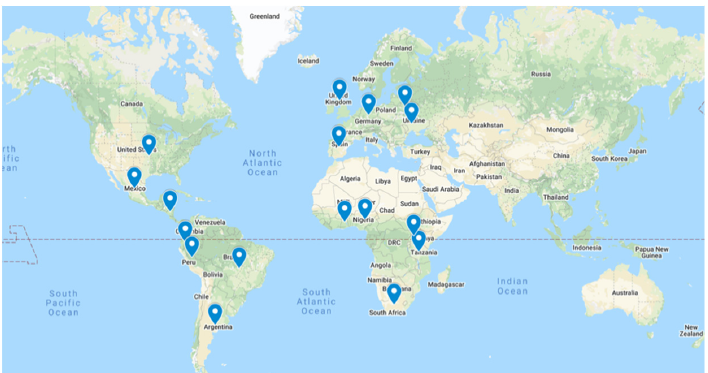
Figure 5. Distribution of National DSpace User Groups worldwide (as of March 2020).